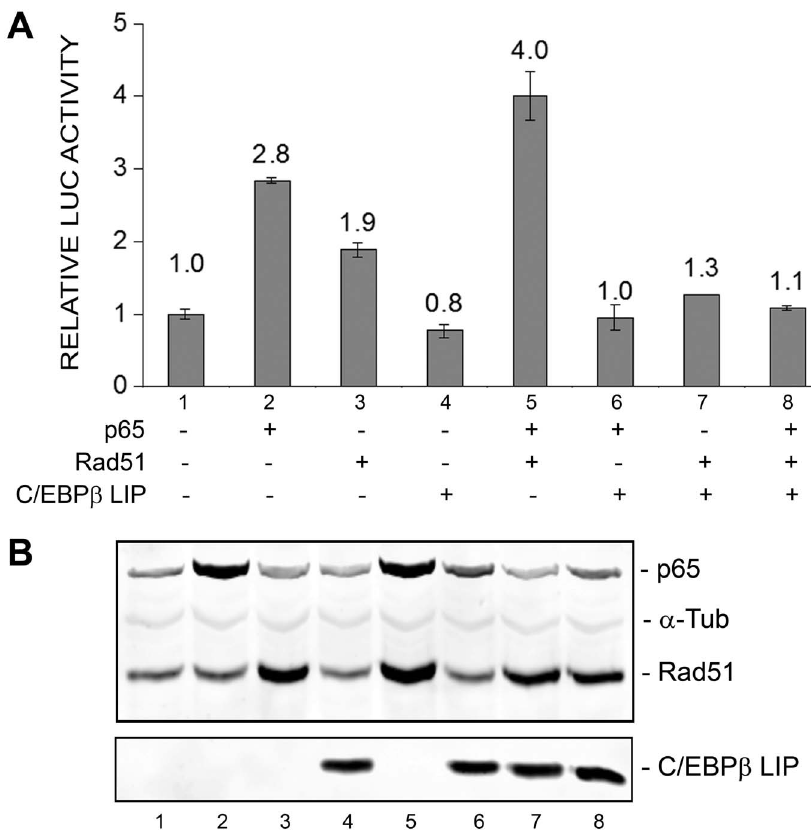
Figure 5. Effect of ectopic expression of Rad51 and C/EBP b on JCV early promoter reporter expression. A. TC620 cells were transfected with JCV E -LUC in the presence or absence of Rad51 (0.5 m g), p65 (0.5 m g) and/or C/EBP b LIP (0.5 m g) expression plasmid in various combinations as indicated. After 48 h, cells were harvested and assayed for luciferase activity. Activities were normalized to the activity for reporter alone. The error bars represent standard deviation. B. Expression of Rad51, p65 and LIP were confirmed by Western blot with a -tubulin as a loading control (lower panel). The lane numbering in the Western blot corresponds to the numbering in the luciferase assay histogram.